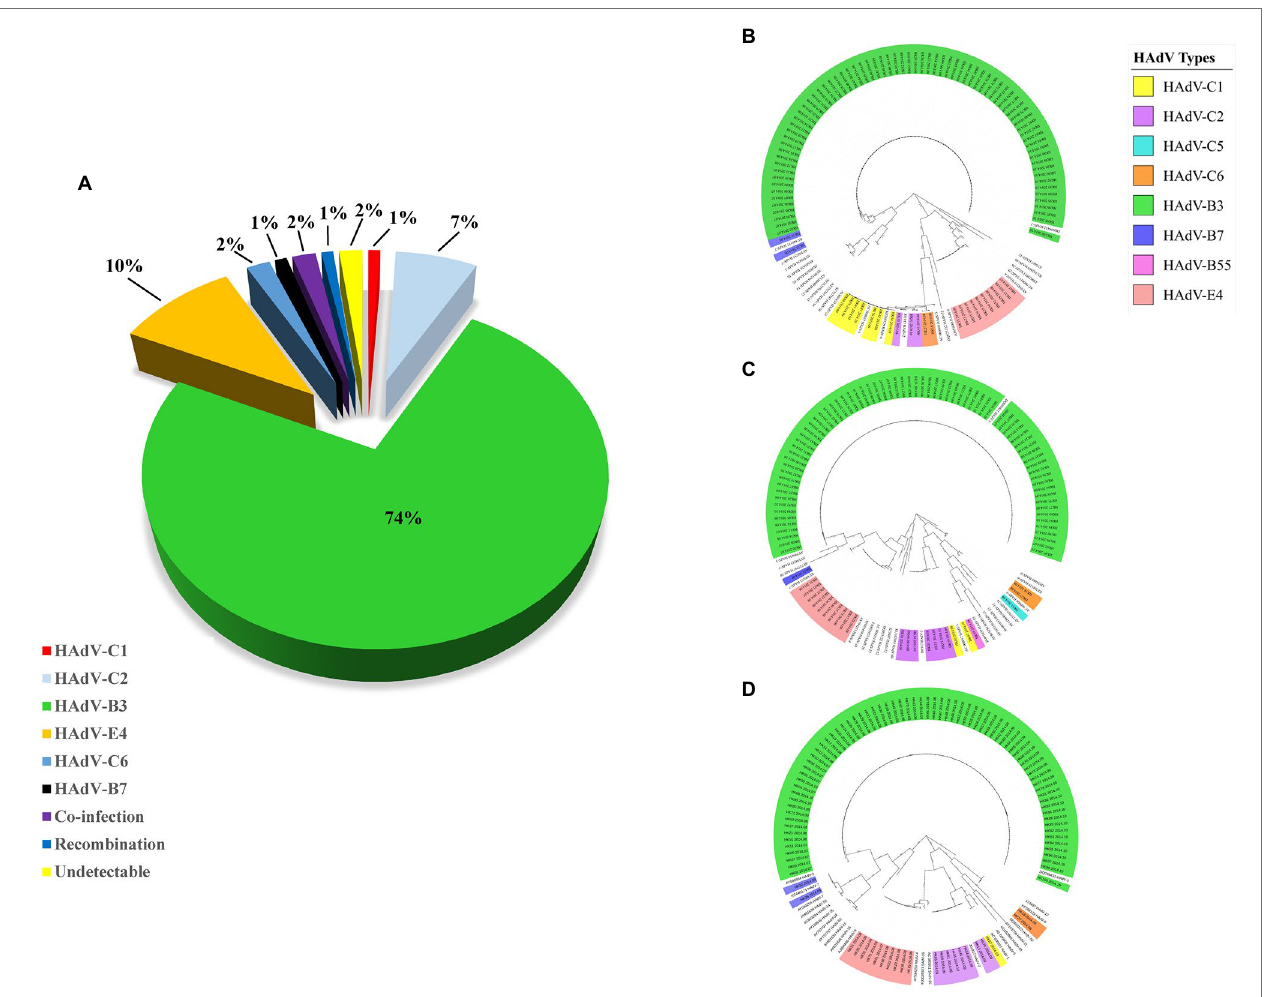
FIGURE 3 | (A) HAdV genotype distribution in hospitalized pediatric patients with ARIs from July through October, 2014. Panels (B–D) display the phylogenetic relationships of the penton base, hexon, and fiber genes, respectively, of the 98 identified HAdV clinical isolates. Additional reference sequences were retrieved from GenBank to provide context and reference. The phylogenetic trees were generated based on the Tree-Bisection-Reconnection (TBR) model by MEGA 7.0 (www. megasoftware.net/) using the maximum parsimony method with 1,000 boot-strap replicates and default parameters. The percentage of trees in which the associated taxa clustered together is shown next to the branches. The scale bar is in units of nucleotide substitutions per